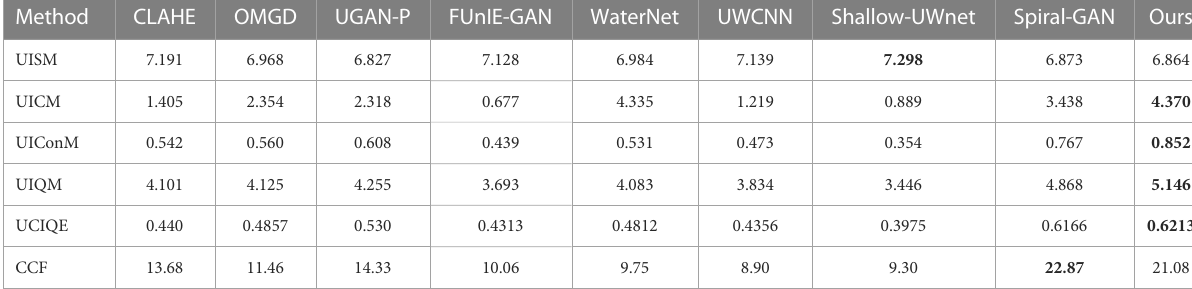
TABLE 3 Quantitative evaluation on the EUVP dataset.